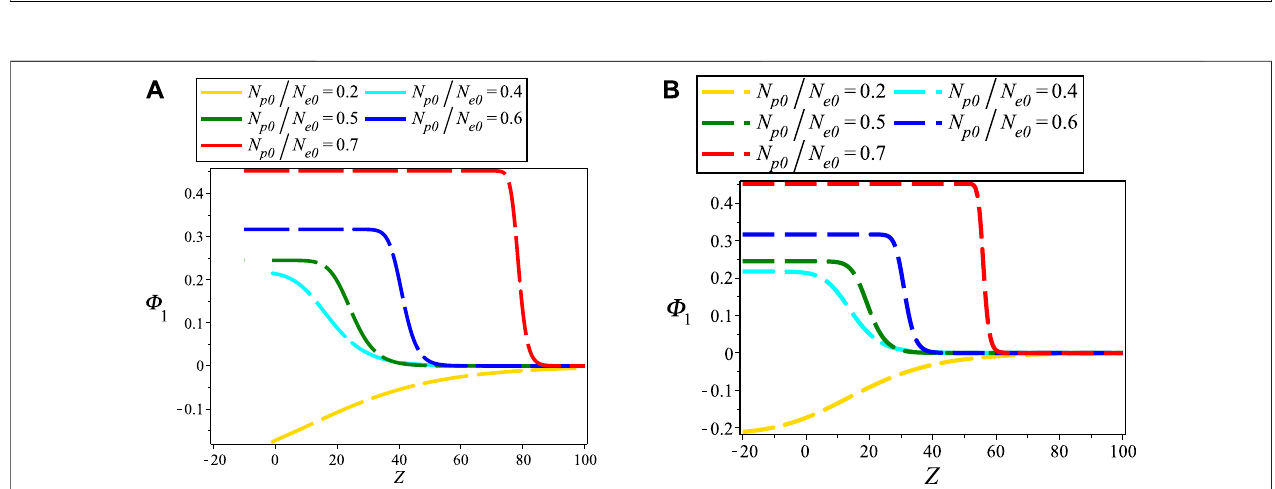
FIGURE 3 | Electrostatic NIASWEs with respect to space ( Z ) and fi xed time ( T (cid:2) 100) for (A) β (cid:2) 0.9 and (B) β (cid:2) 1 with different values of N p 0 / N e 0 . The remaining parameters are considered as d (cid:2) 1, r (cid:2) e , α e (cid:2) 0.5, ρ 0 (cid:2) 0.96, T ep (cid:2) 1 and V i 0 / c (cid:2) 0.1.